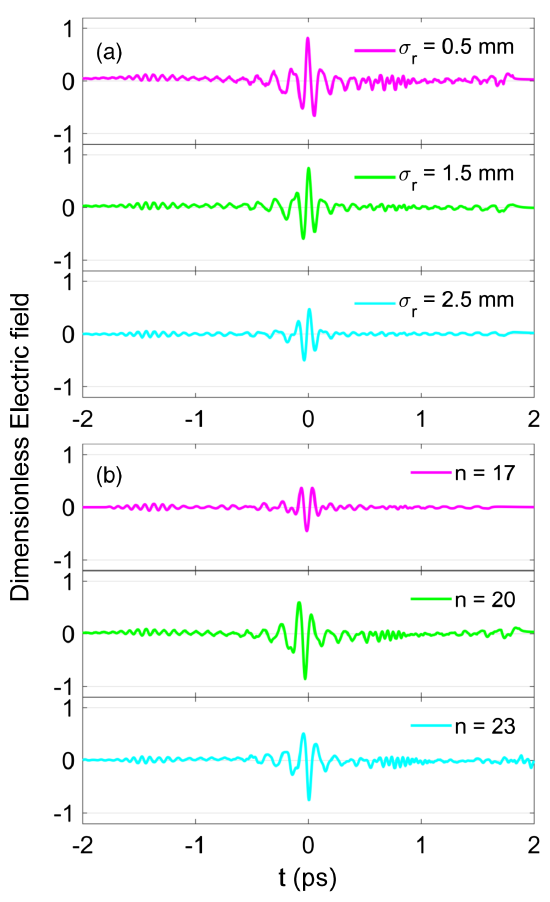
FIG. 8. On-axis electric field with (a) the radial beam size and (b) the microbunch